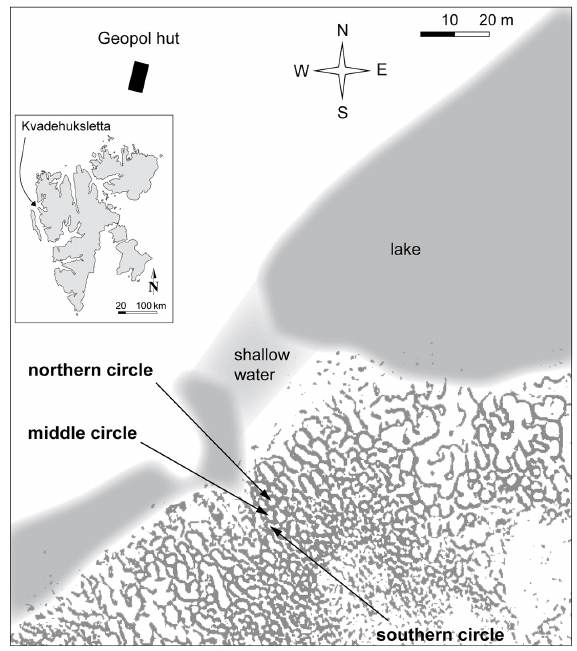
Figure 2. Sketch map of the study site and stone circles investi- gated. The grey pattern shows gravel rings and ridges extracted from a high-resolution satellite image of June 2012. The inset map indi- cates the site location on